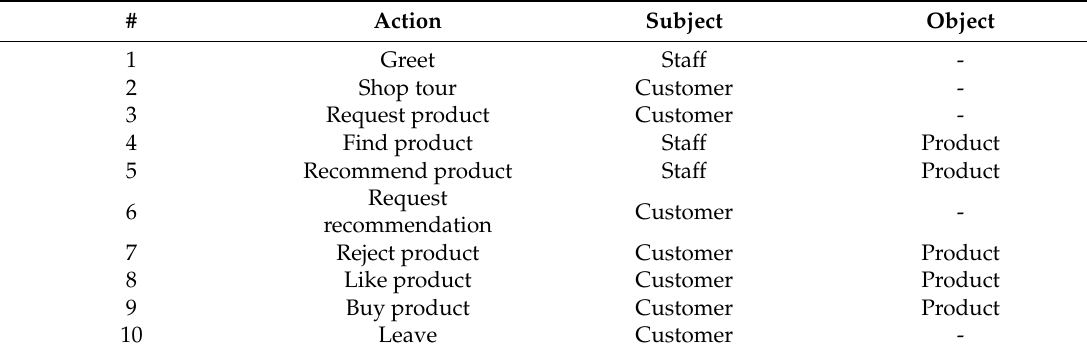
Table 11. Analysis of behaviors in a